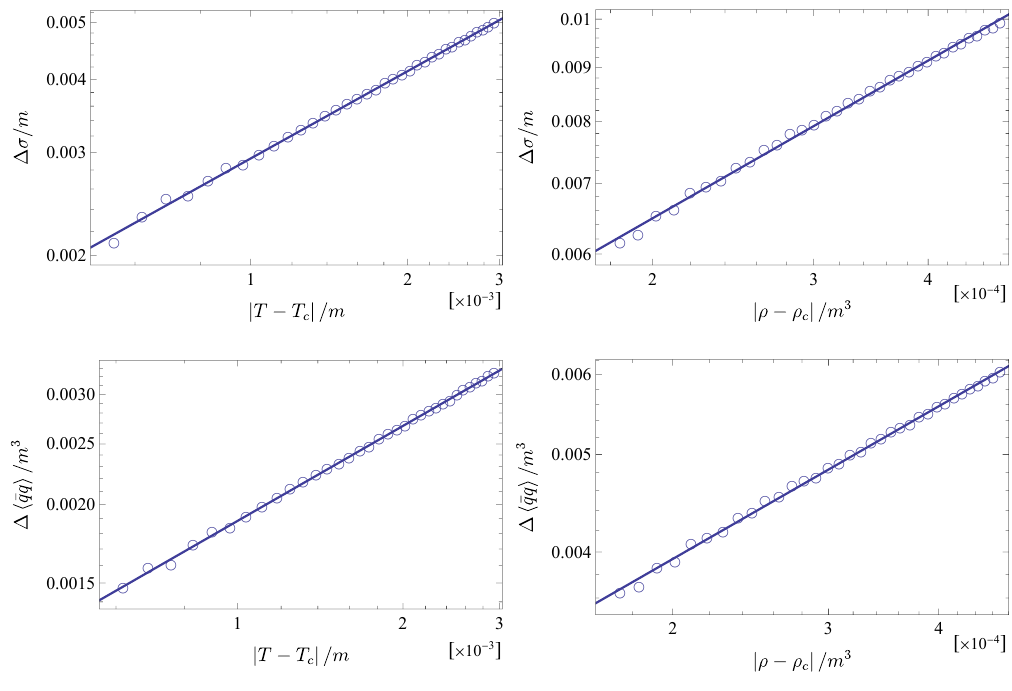
Figure 3 . The critical behaviors of the order parameter. We show the results with the conductivity in the upper panels and those with the chiral condensate in the lower panels. The left (right) panels show the results with κ = T ( κ = ρ ). The open circles and the solid lines denote the numerical plots and the fitting results, respectively. All the plots are shown in a log-log scale.